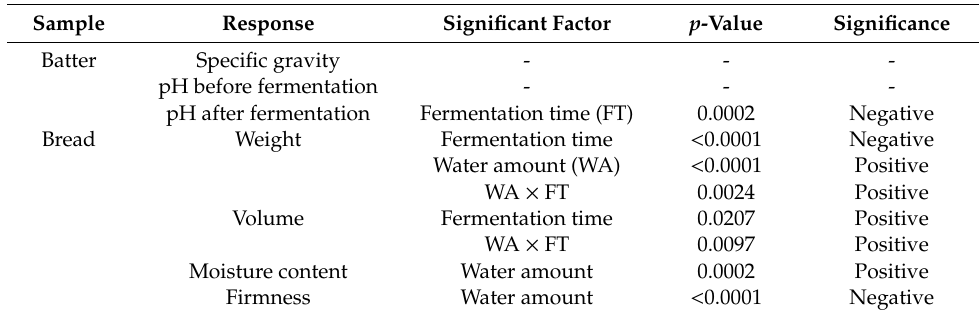
Table 3. Significant factors for the batter and bread characteristics of gluten-free rice bread tested by a full factorial